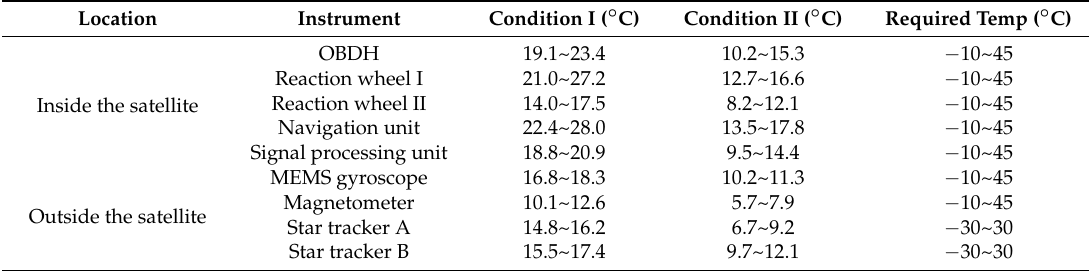
Table 12. Analysis result of the temperature variation conditions of instruments inside and outside the satellite cabin.